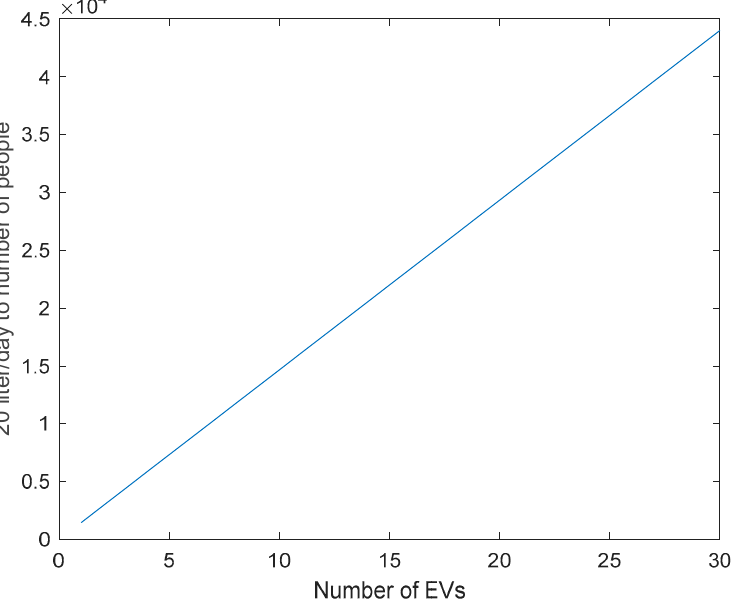
Figure 5. Assuming that several EVs with RO systems are used, the amount of people that could gain 20 L of freshwater from the vehicles is estimated.